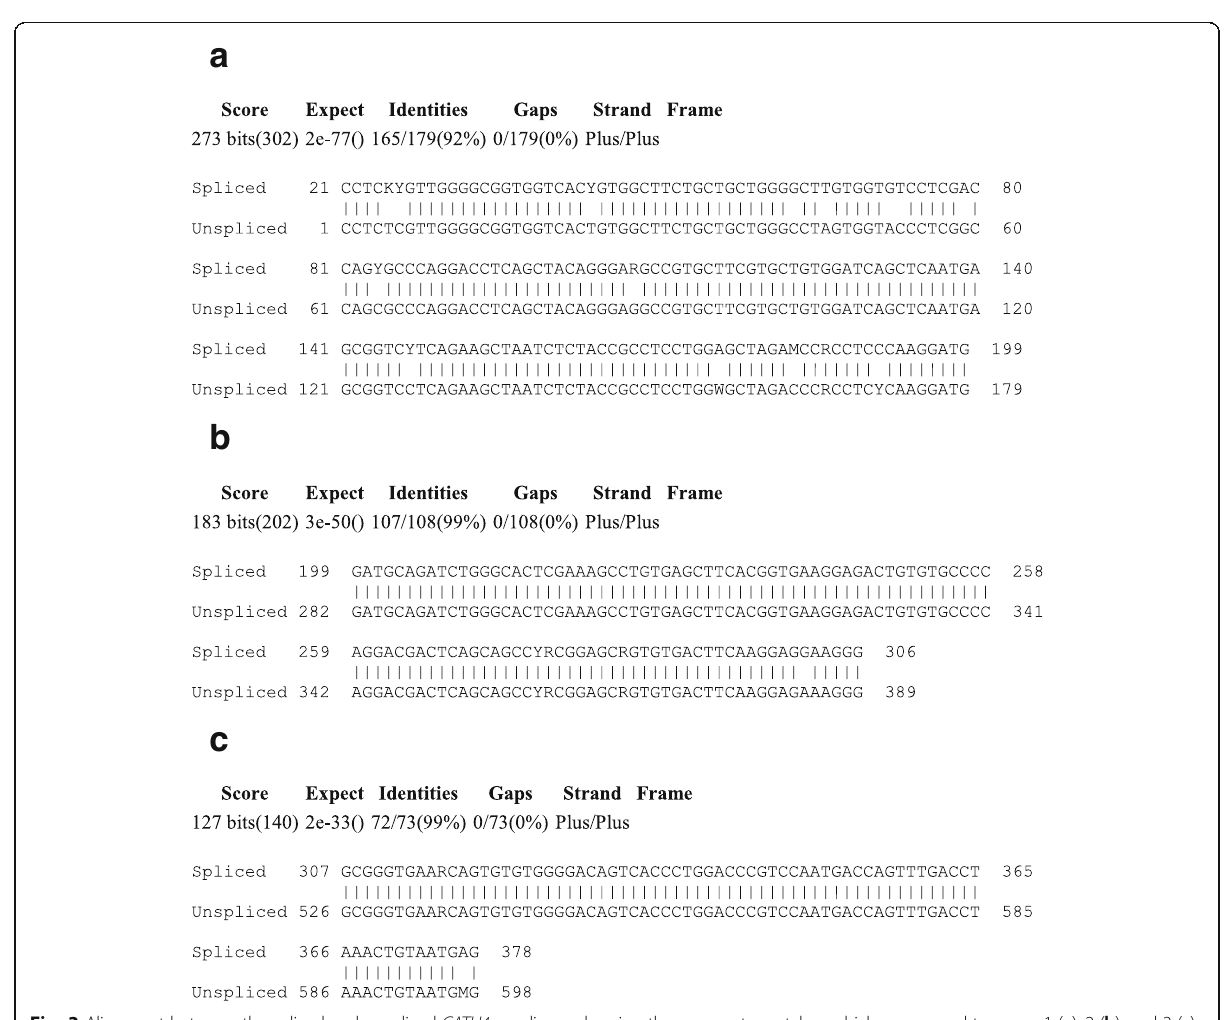
Fig. 3 Alignment between the spliced and unspliced CATH4 amplicons showing three separate matches which correspond to exons 1 ( a ), 2 ( b ), and 3 ( c